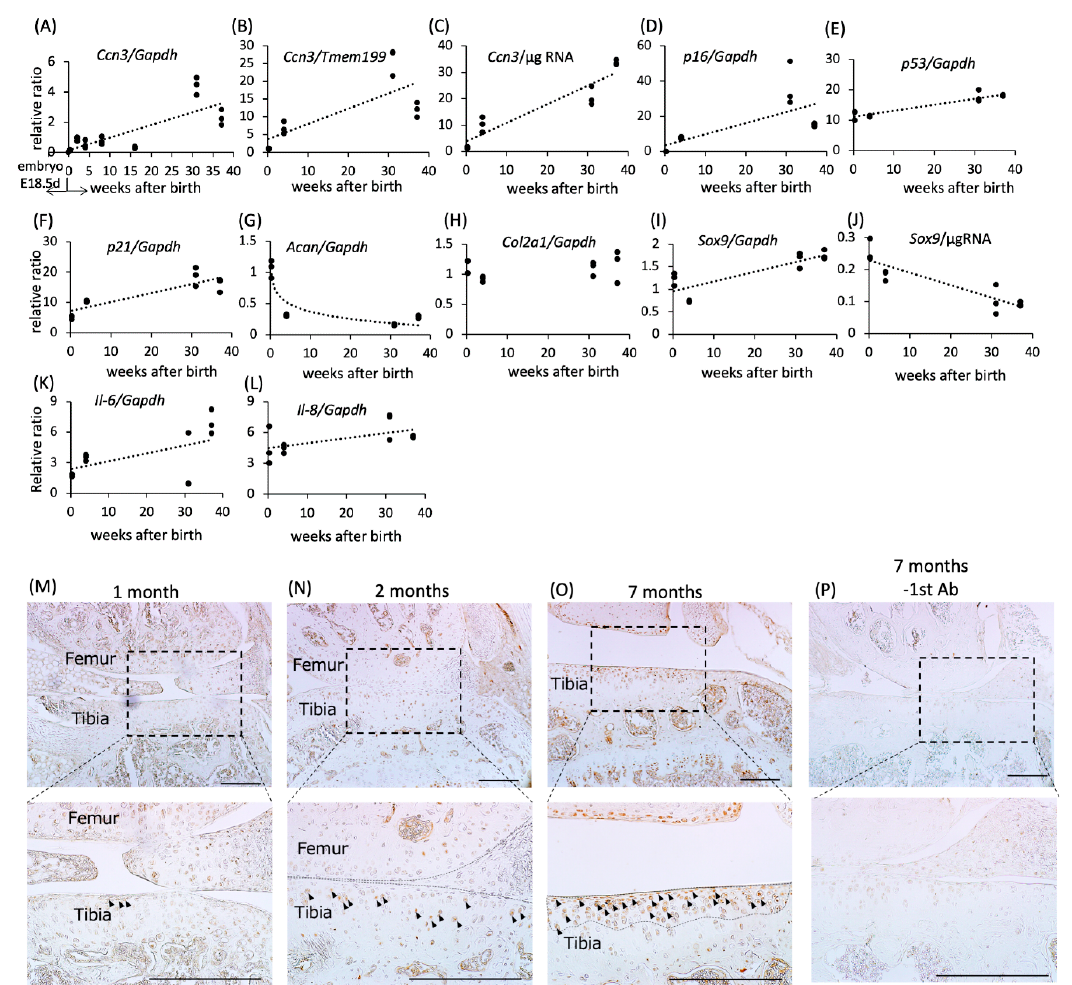
Figure 1. Comparison of mRNA expression levels of ( A – C ) Ccn3 , ( D ) p16 , ( E ) p53 , ( F ) p21 , ( G ) Acan , ( H ) Col2a1 , ( I , J ) Sox9 , ( K ) Il-6 , and ( L ) Il-8 in articular chondrocytes of di ff erent ages (embryo